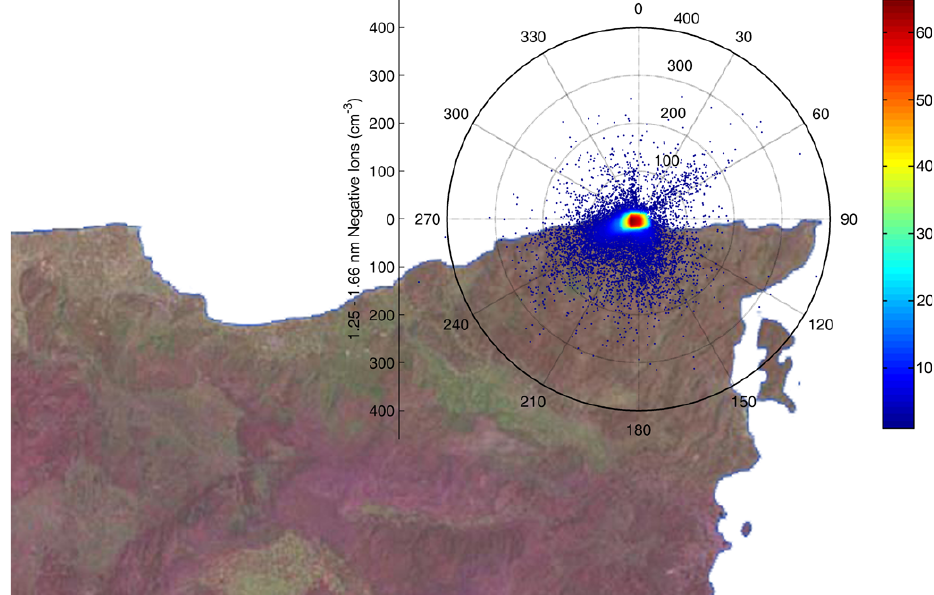
Fig. 11. Dependence of negatively charged atmospheric cluster concentrations at the size range 1.25–1.66nm on the wind